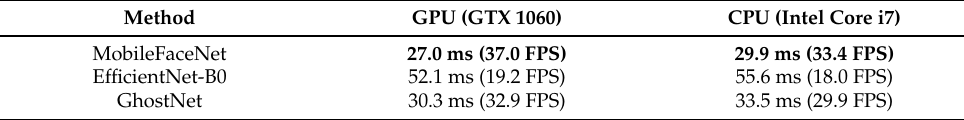
Table 11. Inference